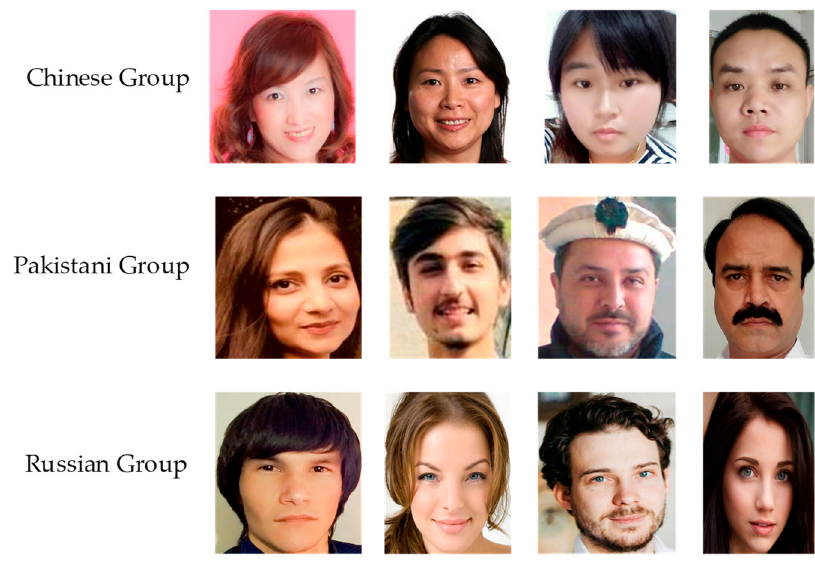
Figure 4. A portion of the new dataset gathered from three separate countries.